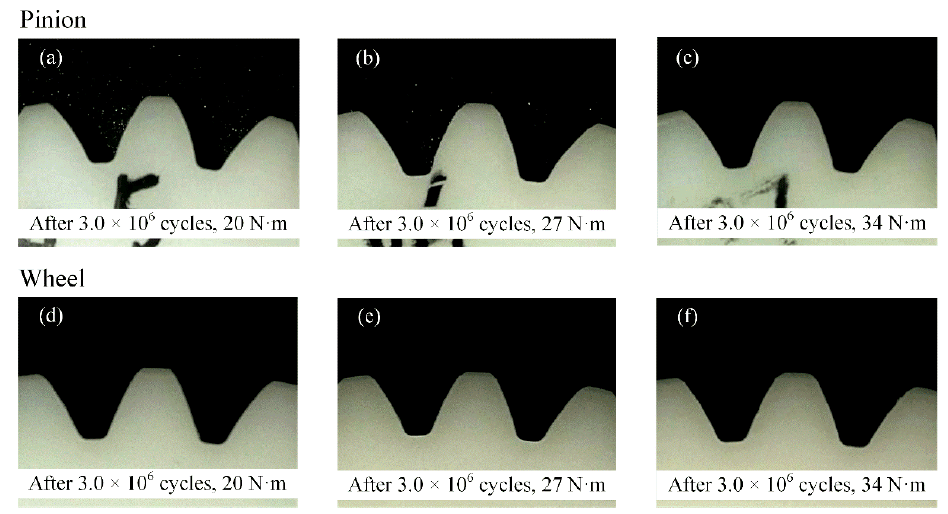
Fig. 16 Tooth damages under the oil-lubricated condition.